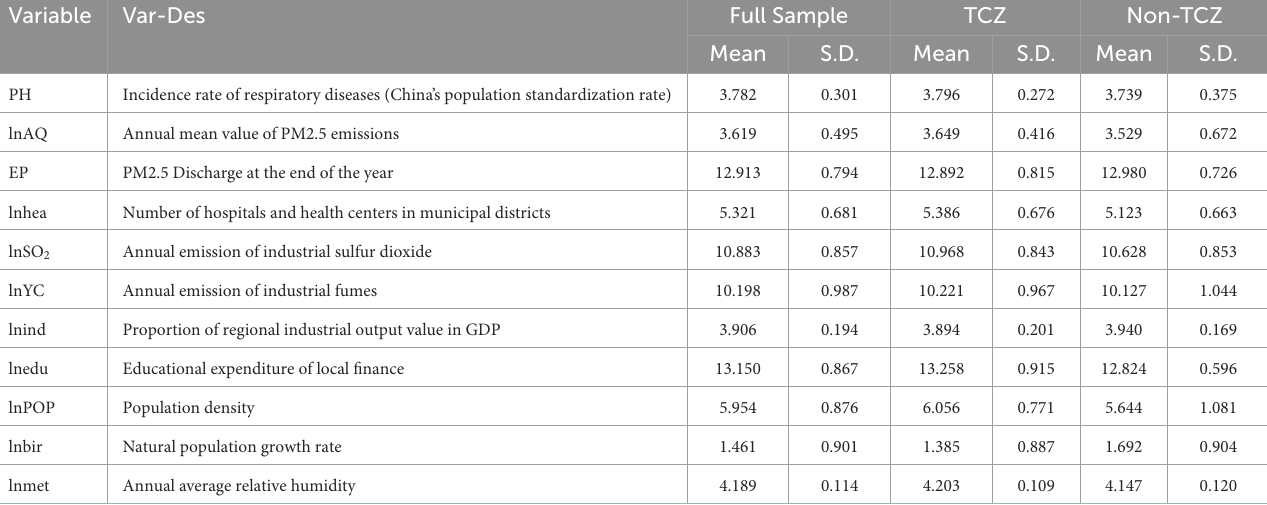
TABLE 1 Descriptive statistics of